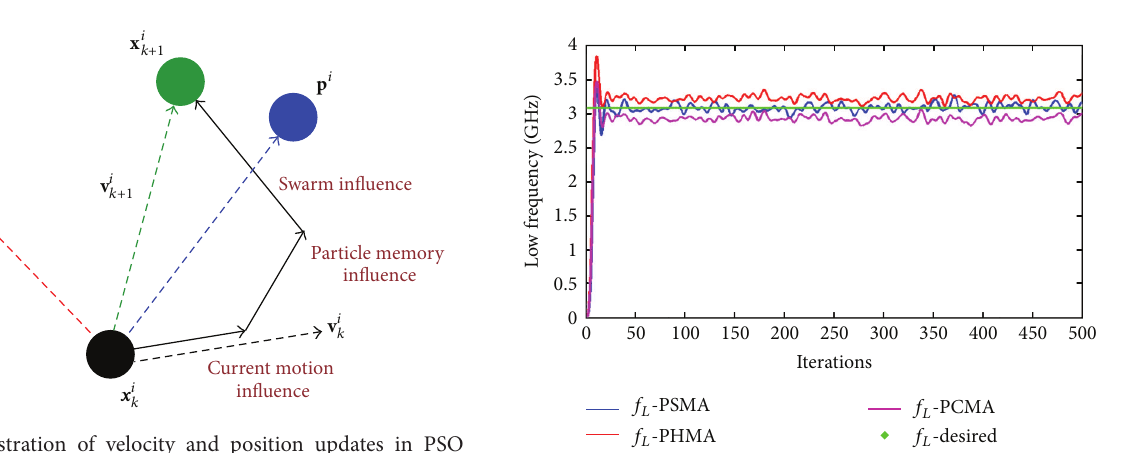
Figure 4: Optimized values of lower frequencies for PSMA, PCMA, and PHMA.